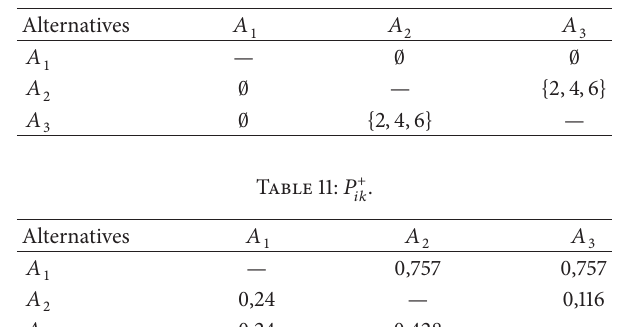
Table 8: Summary of 𝐽 + . Table 9: Summary of 𝐽 − . Table 10: Summary of 𝐽 = .